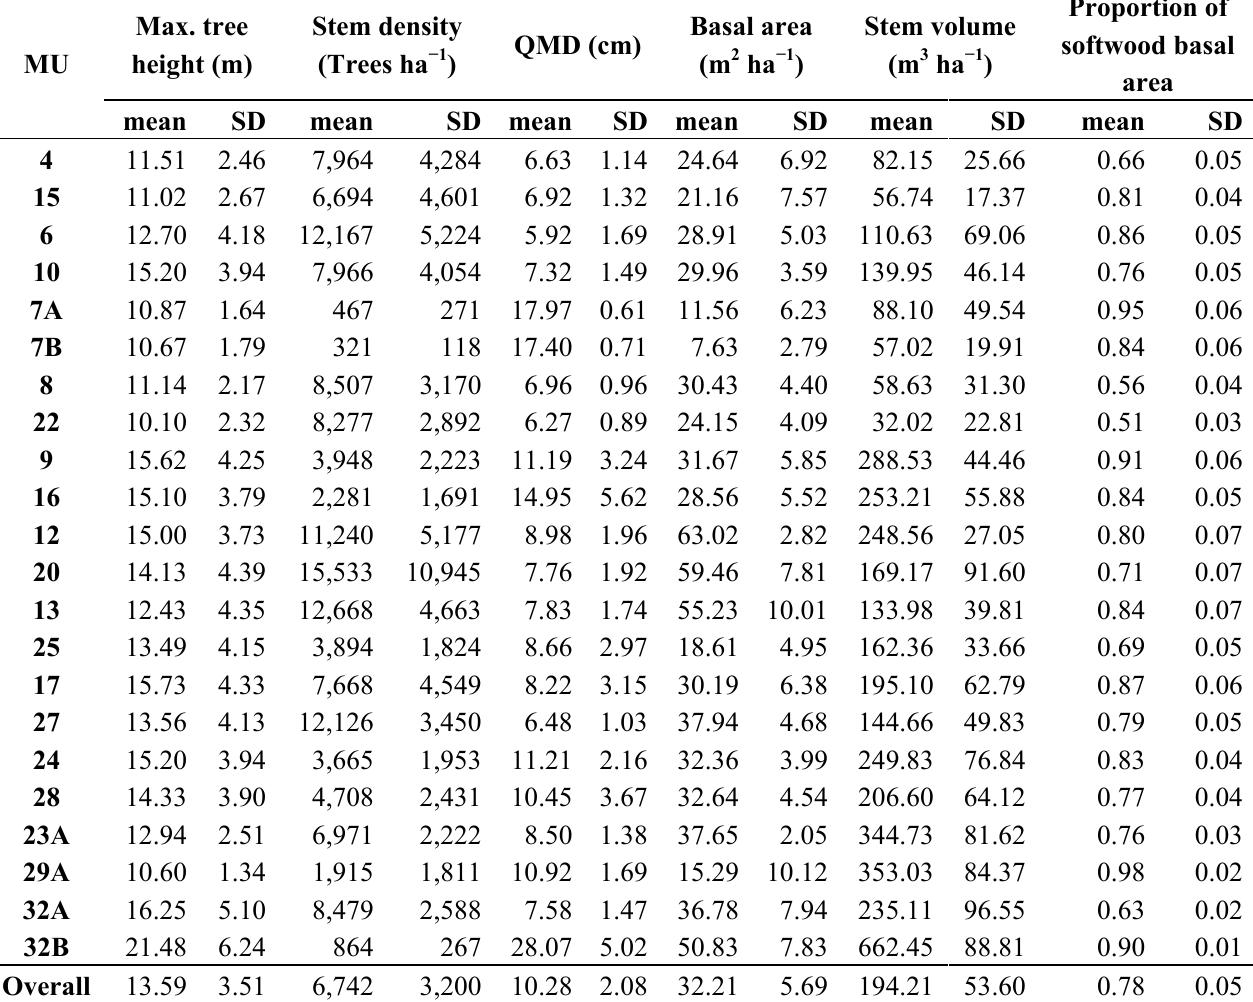
Table 2. Examined attributes (mean ± standard deviation) by management unit